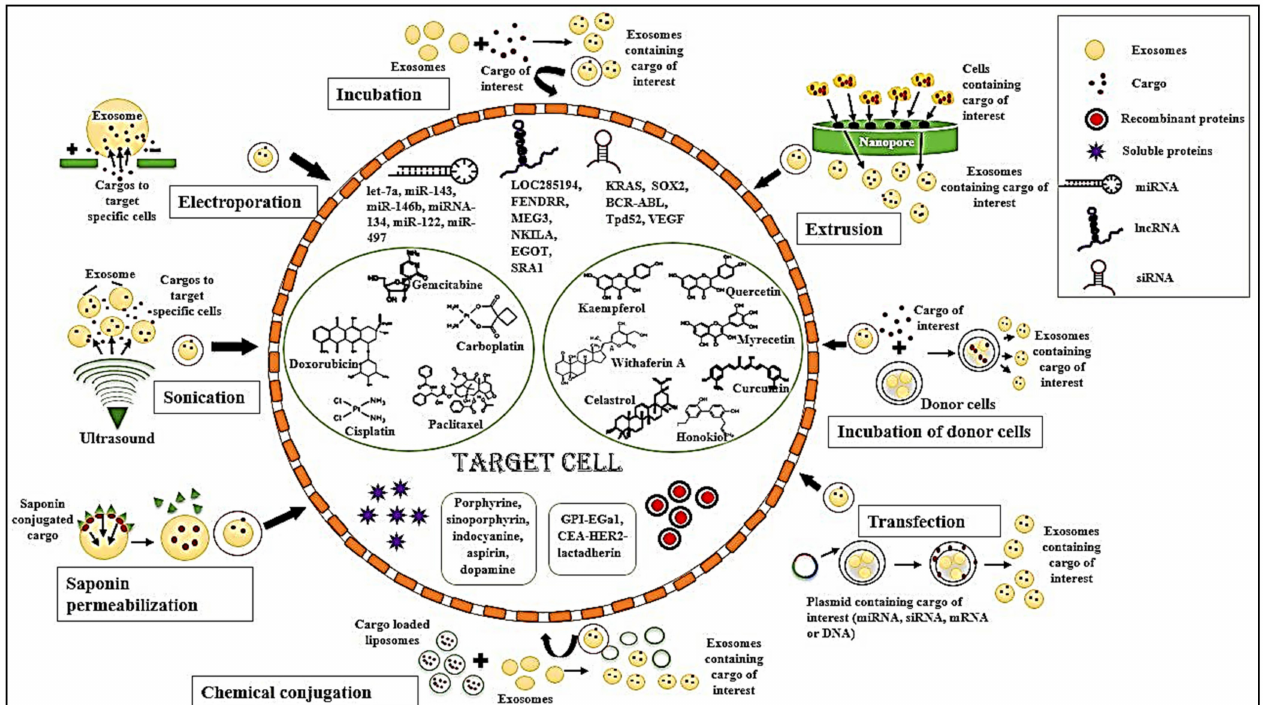
Figure 1. Bioengineering of exosomes: Different methods of cargo incorporation into exosomes and different types of cargo internalized in the exosomes targeted to various target